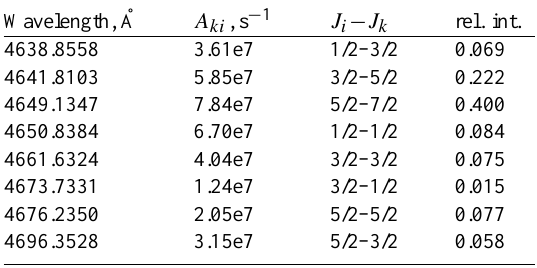
Table 1. Lines of the O + 4 P- 4 D 0 multiplet (NIST Atomic Spec- tra Database, http://physics.nist.gov/PhysRefData/contents-atomic. html).